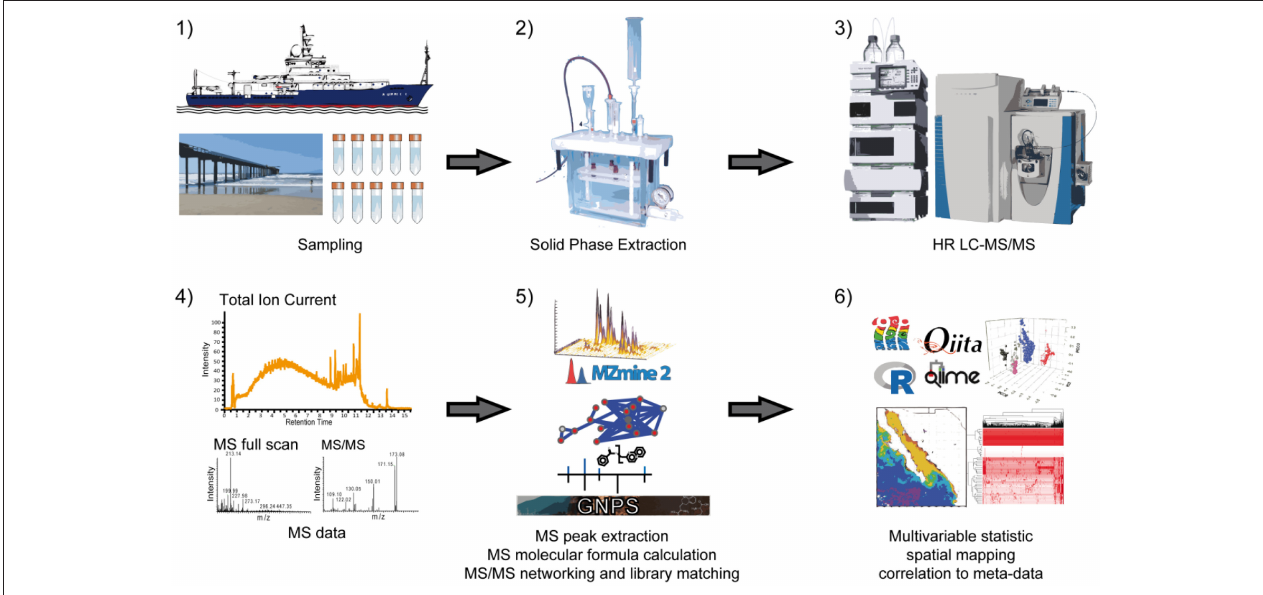
FIGURE 1 | Overview of data acquisition and data analysis workflow. After sampling of sea water (1), dissolved organic matter is extracted by solid phase extraction (2) and samples are analyzed by non-targeted high-resolution liquid chromatography tandem mass spectrometry (HR LC-MS/MS) in data dependent acquisition mode (3). Following raw data acquisition (4), extracted ion chromatograms (XICs) are created and relative feature intensities are defined through integration of peak areas (5). For molecular annotation of features, molecular formulas based on exact masses of the XICs from negative and positive ionization experiments are calculated and spectrum library comparison of MS/MS spectra as well as spectral networking is performed (5). To facilitate the analysis of data, multivariable statistics such as Principal Coordinate Analysis (PCoA) can be performed in order to display sample-sample distance, and metabolite data can be interpreted in the context of oceanographic features and microbial community composition